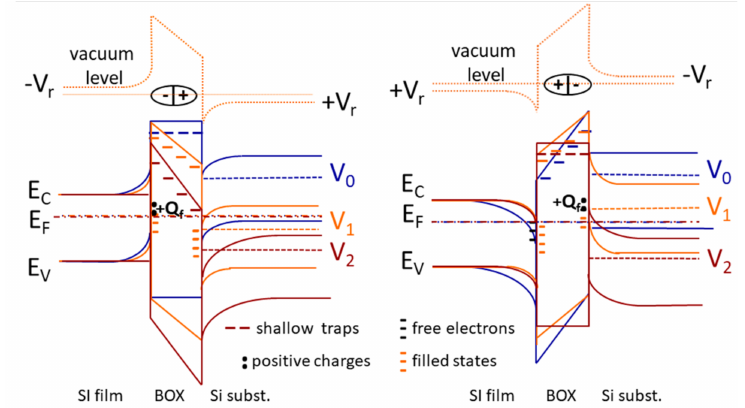
Figure 8. Silicon and hafnia bandgaps (not on the same energy scales for picture clarity) bending at the ferroelectric switching in the symmetric n-SIS structure with the two polarizations down to the substrates (left) and to the Si film (right), the shallow and deep electron traps with the +Q f net trapped charges at the boundaries of ferroelectric stack HfO 2 :Al 2 O 3 (10:1) for the different Si substrate bias voltage V sub : V 0 = -V R , where V R is the residual polarization voltage after/before the P-down switching (left), V 1 = 0 V, V 2 = V R , where V R is the voltage for the coercive switching of polarization (left). The same for the P-up switching in the built-in insulator (right). The Si film is grounded. The vacuum levels are shown for the V 1 voltages only.